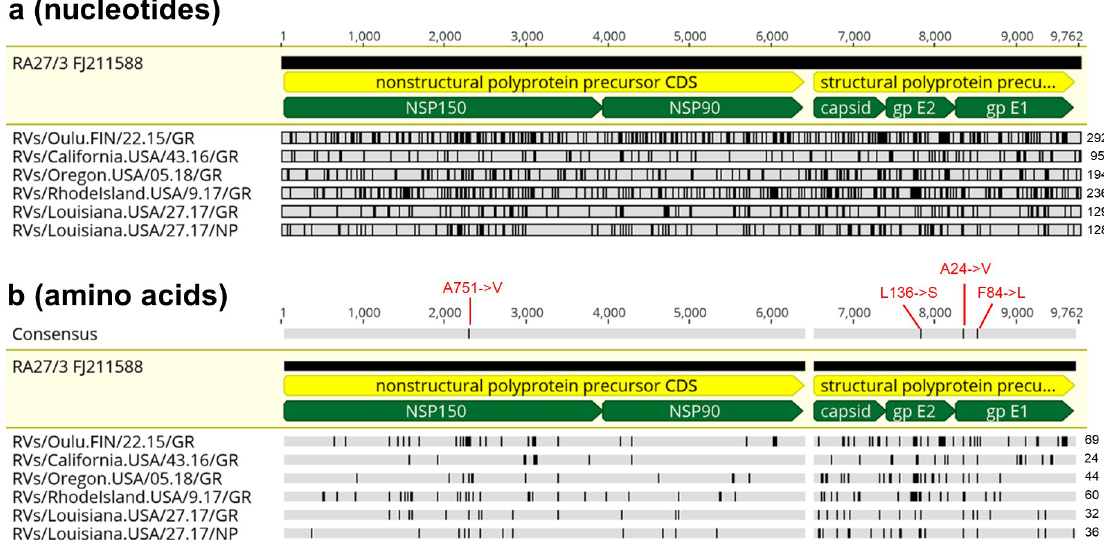
Fig 2. Diversity of iVDRV sequences. a. Nucleotide and b. amino acid substitutions in iVDRV genomes relative to parental RA27/3 virus (GenBank #FJ211588) are depicted as vertical lines. The total number of substitutions are shown for each iVDRV on the right side. The consensus in b. represents amino acids identical in > 50% sequences with the shared substitutions shown in red above the consensus; the indicated positions in the substitutions were the positions in the corresponding RV proteins. The positions of the coding sequences (CDS) and proteins are indicated by dark yellow and green pointed bars, respectively. The reference sequence is indicated by light yellow shading. The figure was prepared with Geneious software.